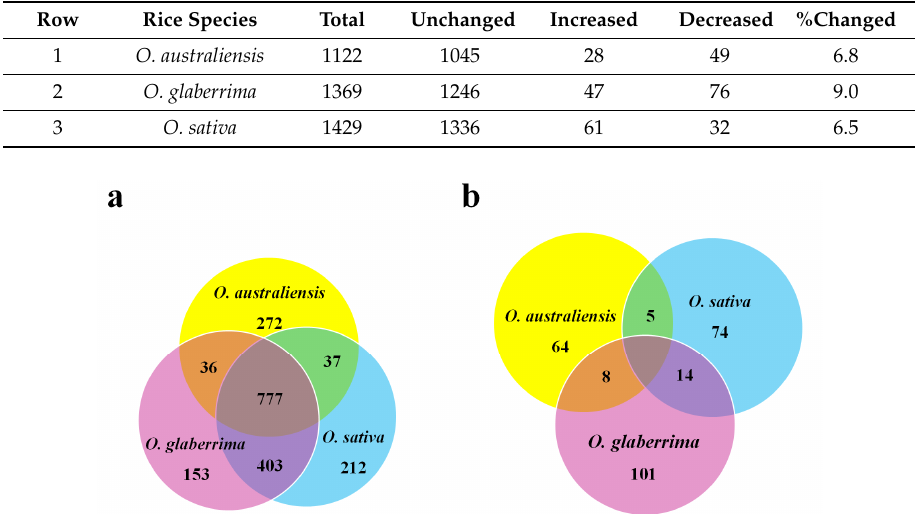
Figure 2. Profiling of identified proteins in three species of rice: ( a ) Venn diagram of reproducibly identified proteins from each species. ( b ) Venn diagram of proteins differentially changed in abundance in stress conditions from each species.